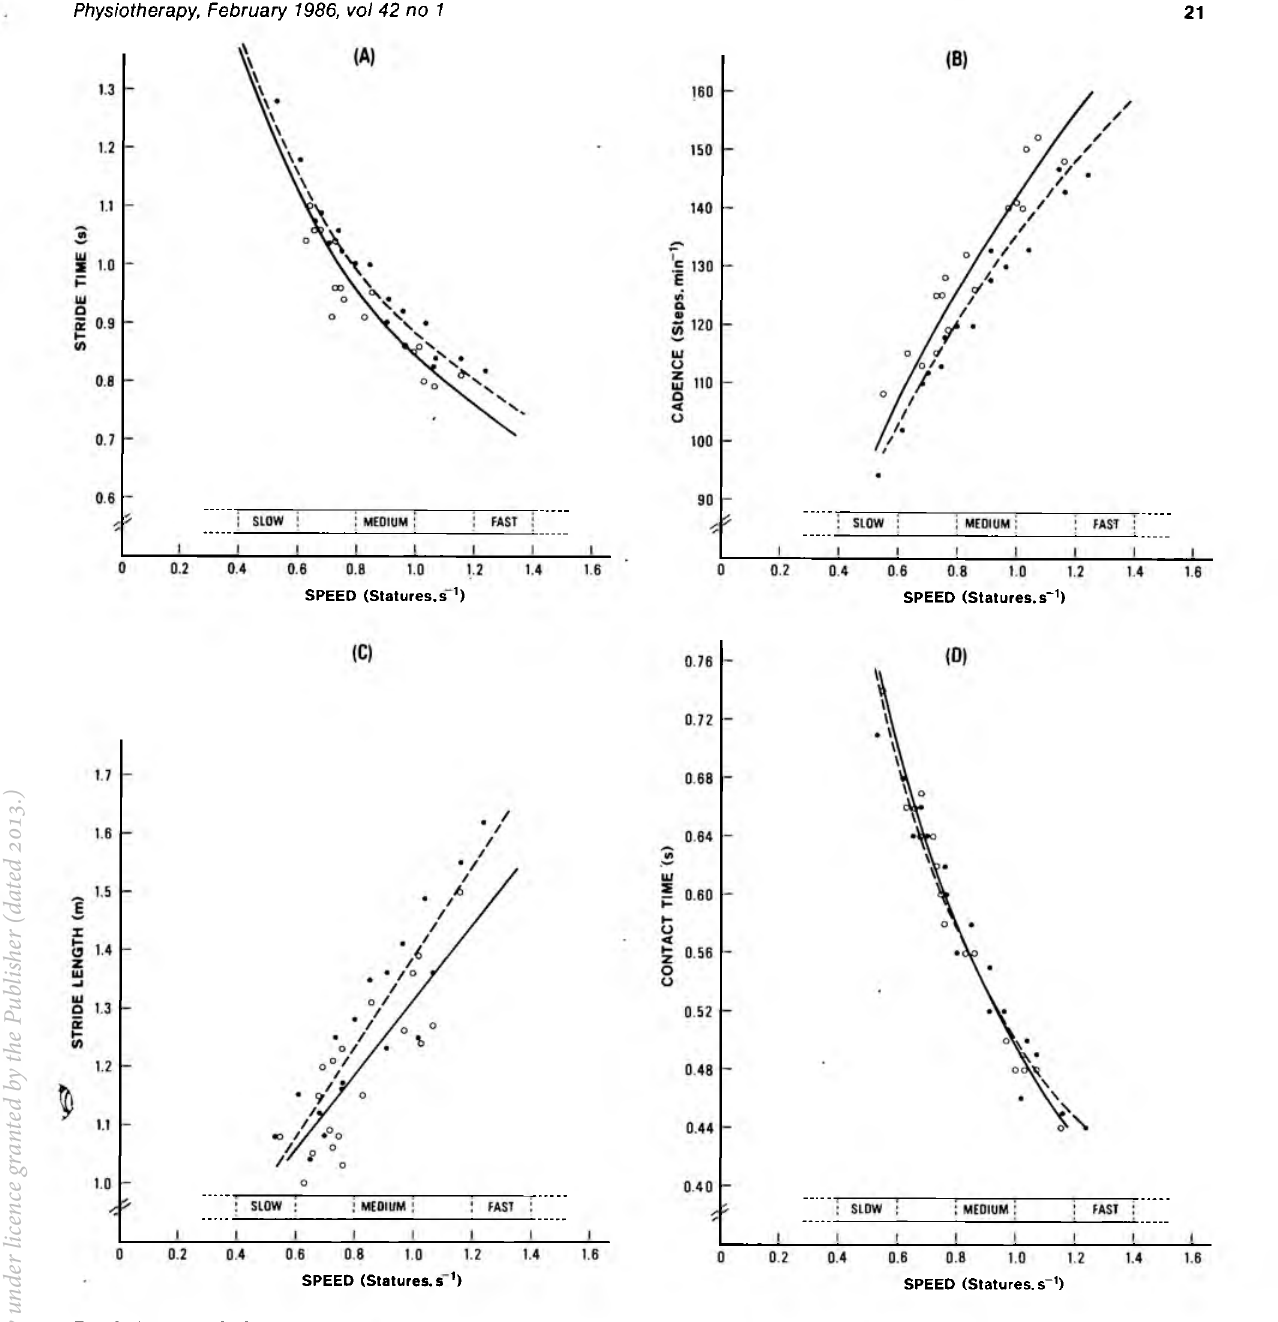
Fig. 3. Temporal, distance and rate parameters o f the overall pattern. Broken line represents unloaded condition; solid line represents loaded condition. tively, and to increase the stable portion of the cycle. By inference, if single support (hence swing) is shorter, but overall contact (Fig. 3(D)) is absolutely the same and relatively longer, it must mean that the periods of double support, necessarily the most stable, are abso­ lutely and relatively